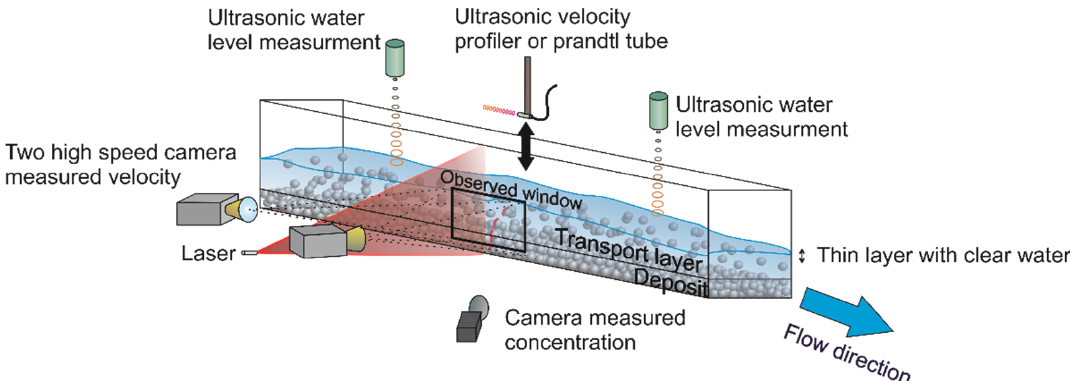
Figure 3. Schematic layout of tilting flume and measuring equipment in Water Engineering Laboratory [26].